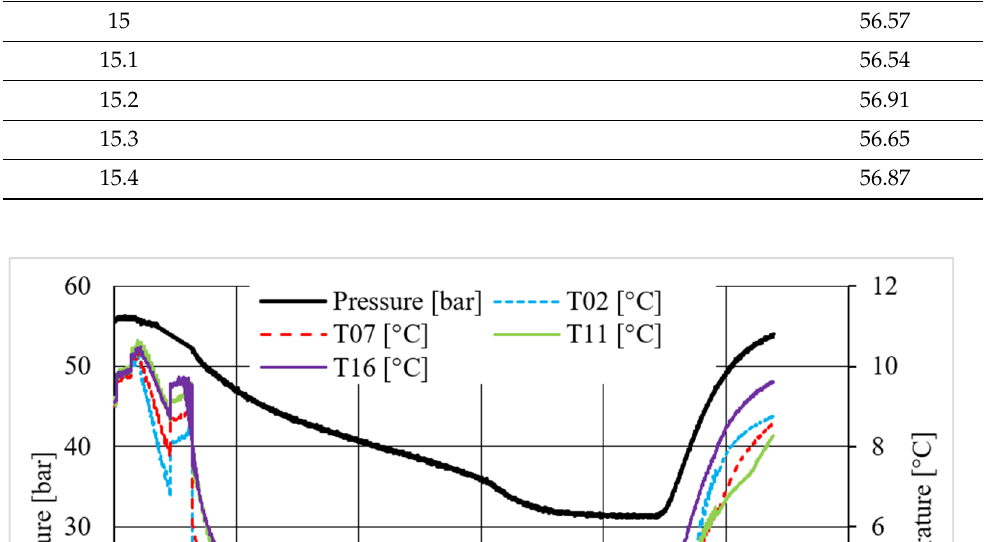
Figure 6. Pressure vs. temperature, describing methane hydrate formation in the absence of CuSn12 powder.